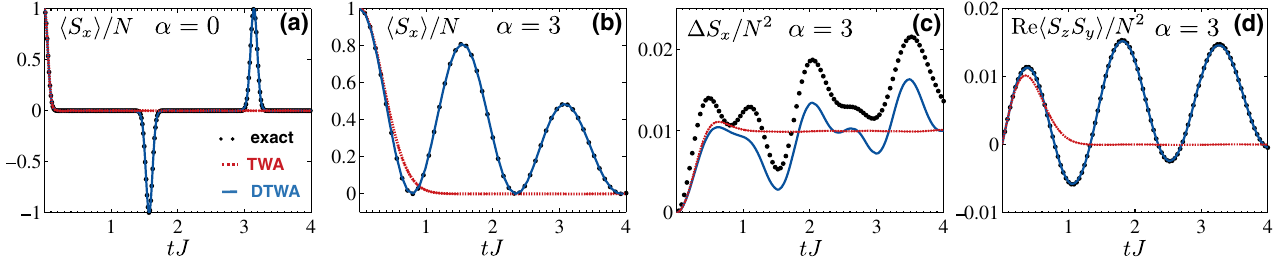
FIG. 2. Dynamics for Ising interactions. Circles denote the exact solution, dashed lines are traditional TWA results, solid lines denote DTWA results, for 1D, N ¼ 100 spins. (a),(b) Evolution of h S x i , for all-to-all (decay exponent α ¼ 0 ) and dipolar ( α ¼ 3 ) interactions, respectively. Traditional TWA captures only the initial decay and no oscillations or revivals. In contrast, DTWA becomes exact (on top of the black symbols). (c),(d) The evolution of the correlation functions Δ S x ¼ h S 2 x i − h S x i 2 and Re h S y S z i for dipolar interactions. While Re h S y S z i is exactly captured in DTWA, Δ S x shows deviations. DTWA improves traditional TWA predictions in all panels.